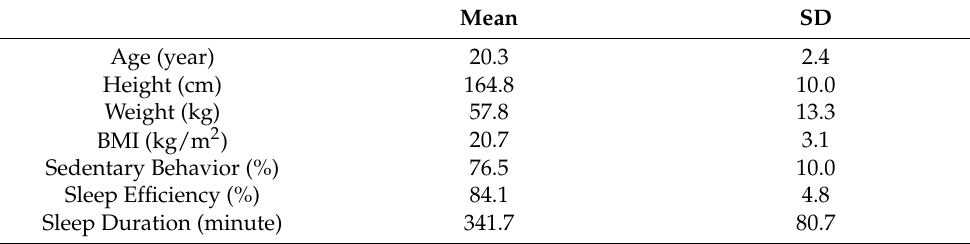
Table 1. Characteristics of study participants and descriptive statistics of study outcomes ( n = 220).